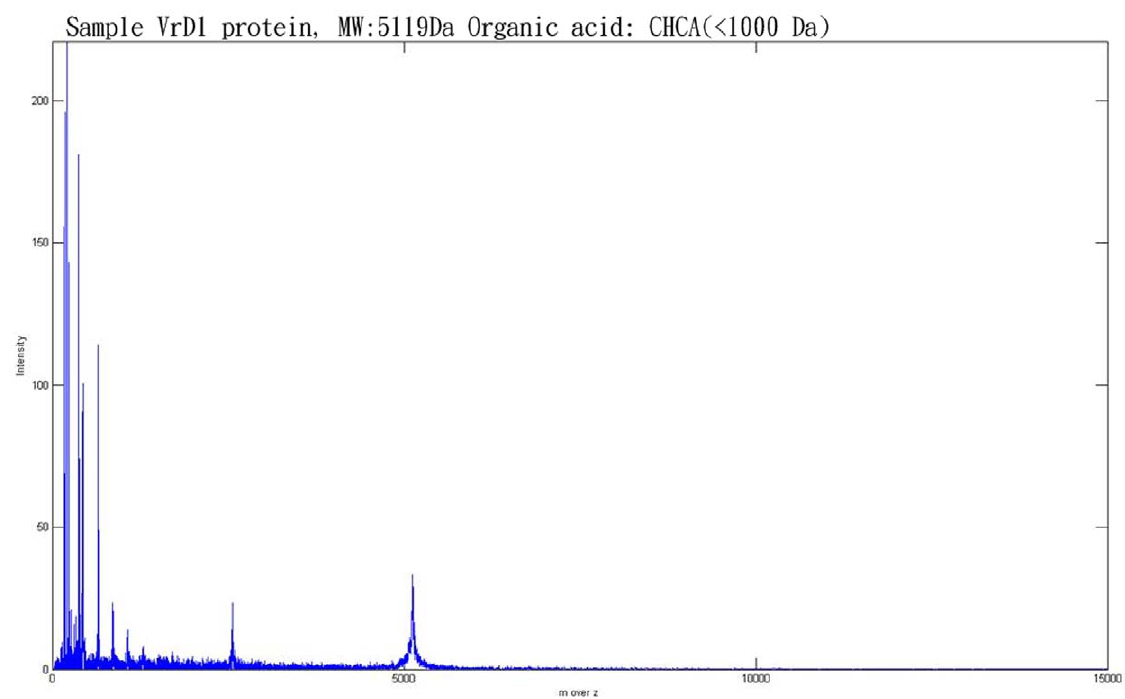
Figure 10. The spectrum of VrD1. VrD1 is a small protein with a molecular weight of about 5119 Da.